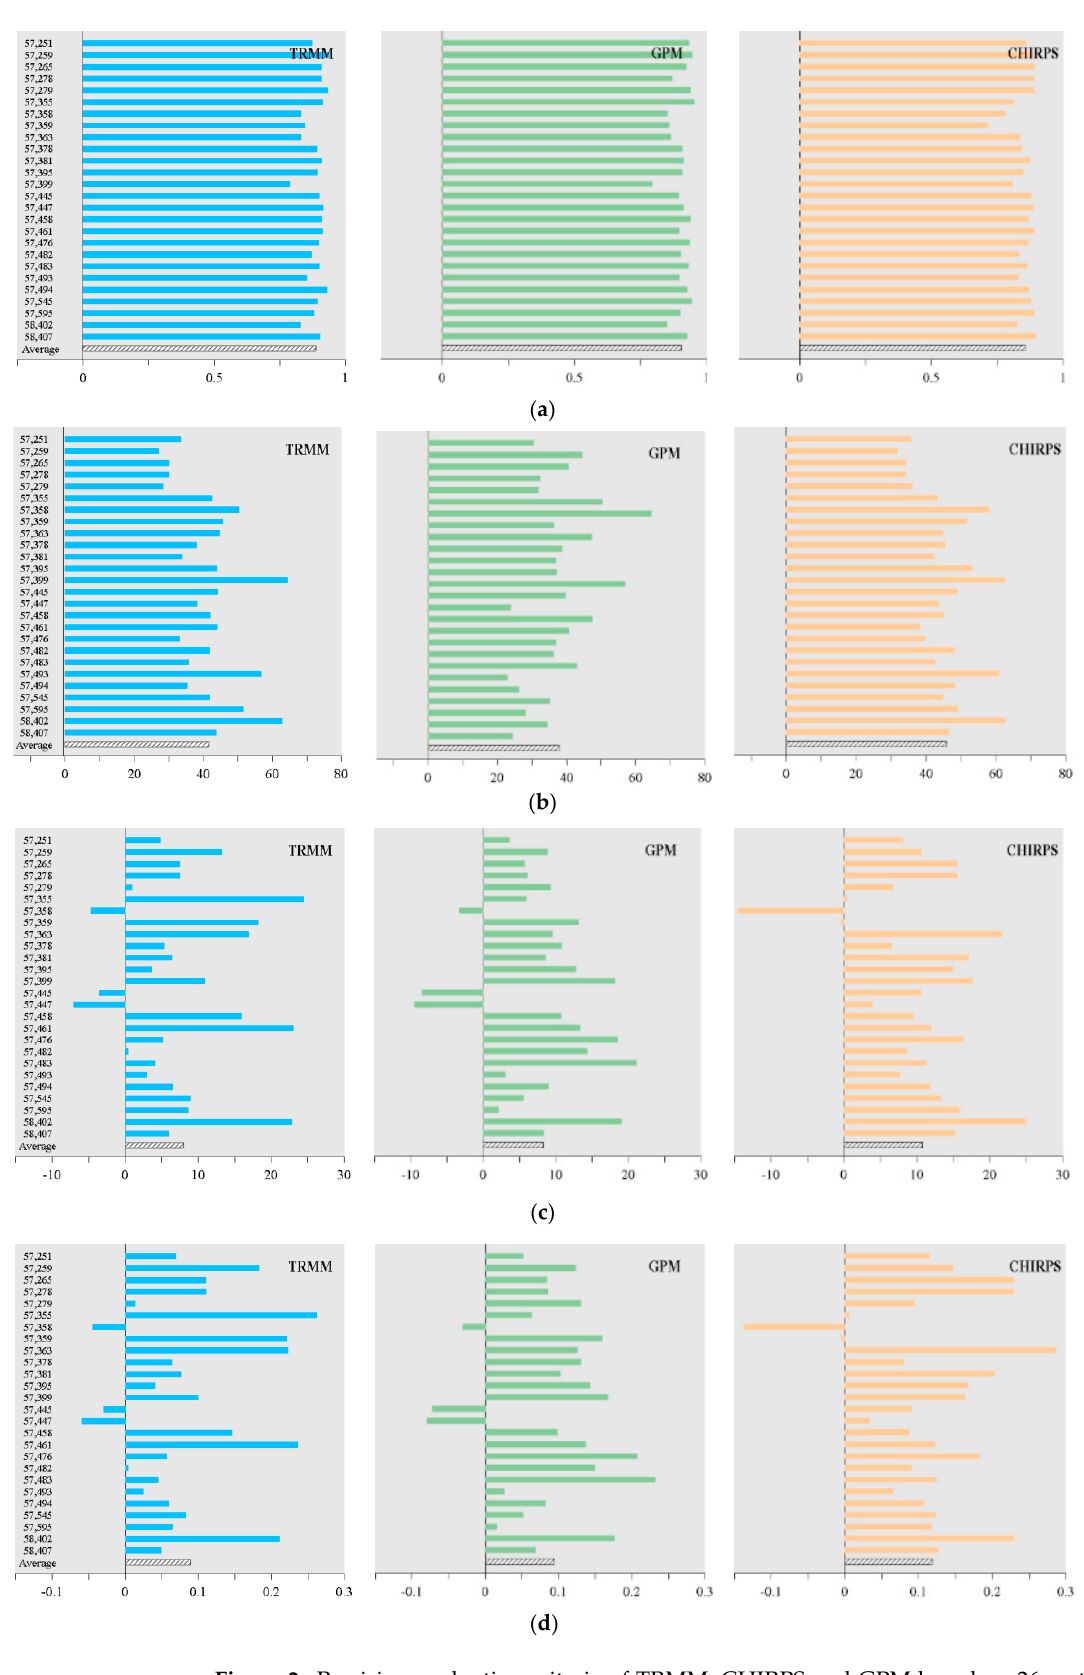
Figure 2. Precision evaluation criteria of TRMM, CHIRPS and GPM based on 26 meteorological stations (( a ) CC , ( b ) RMSE , ( c ) ME , and ( d ) BIAS ).